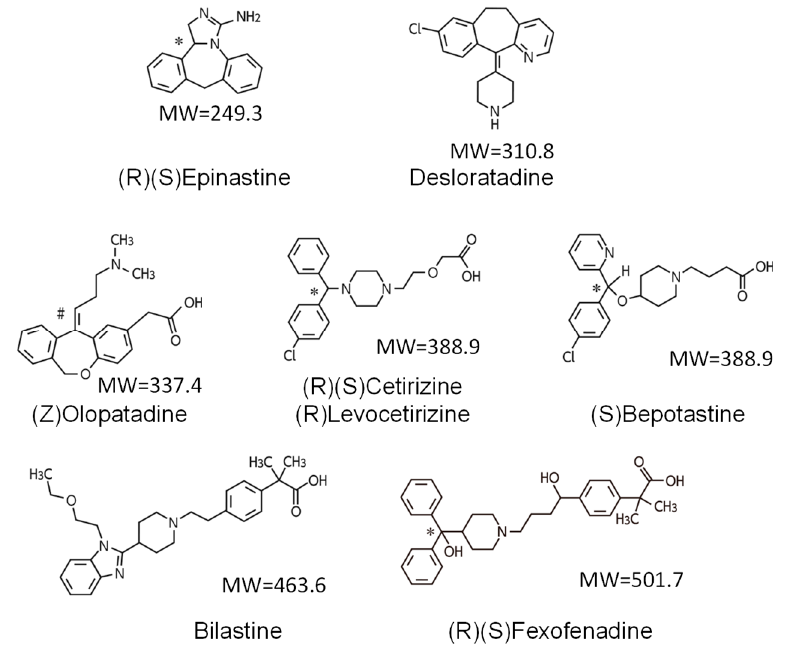
Figure 3. Chemical structures of several non-sedating antihistamines. There are two types of non-sedating antihistamines: the amino group type (epinastine and desloratadine) and the carboxy group type (the others; zwitterionic compounds). MW, molecular weight; (R), (S), optical isomers; (Z), geometric isomer; *, the carbon atom that is related to optical isomerism; #, the double bond that is related to the structurally different geometric isomer ( cis - trans isomer) without optical isomerism. The carboxy group types are characterized by high specificity to H 1 R, while the amino group types bind to other GPCR receptors such as muscarinic receptors. Note that the mean molecular weight of marketed CNS drugs is approximately 310 Da and that the molecular weights of fexofenadine and bilastine are larger than others.